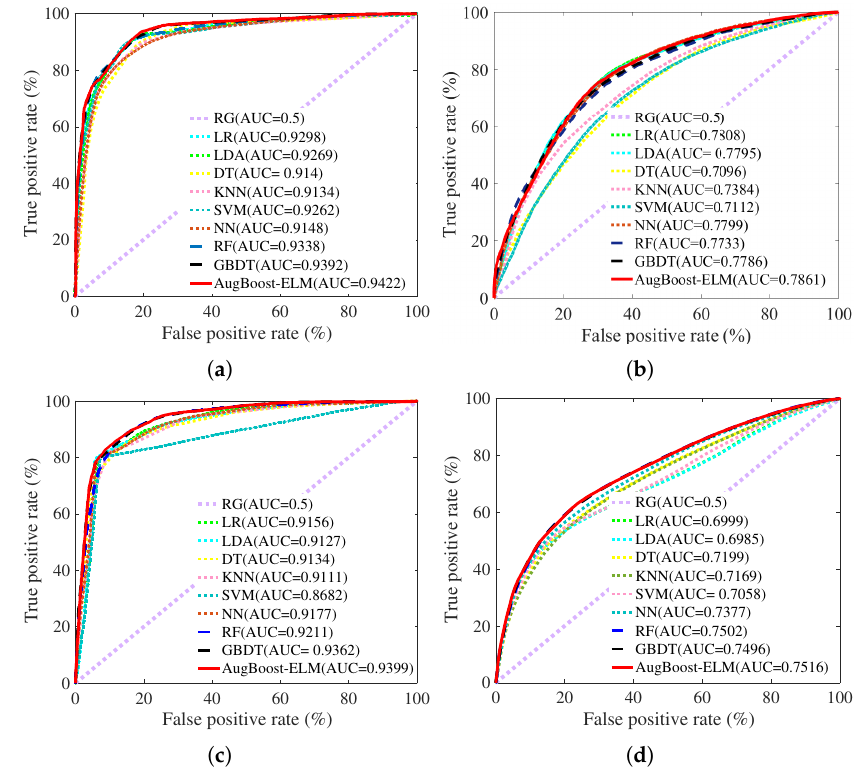
Figure 2. ROCs comparison of benchmark credit scoring models for credit datasets: RG represents the curve of random guess. ( a ) Australian, ( b ) German, ( c ) Japanese, ( d )